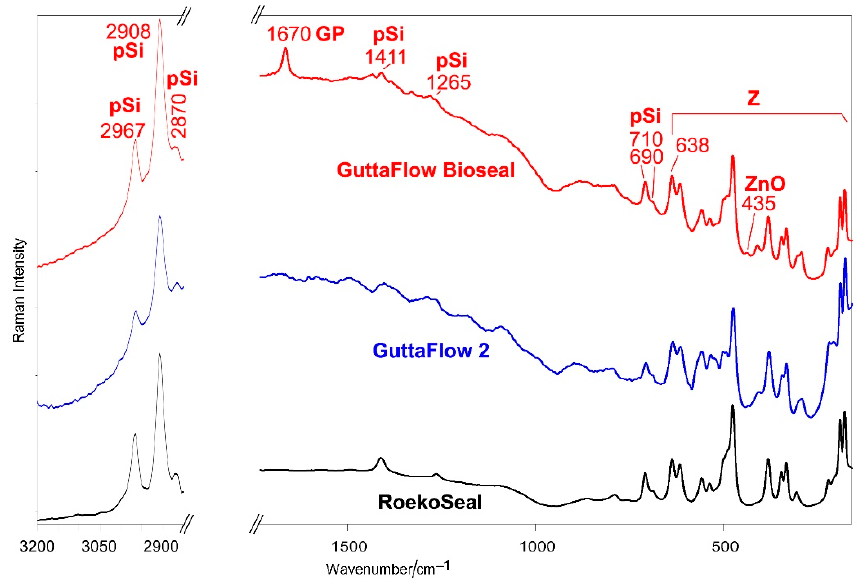
Figure 5. Average FT ‐ Raman spectra of fresh RoekoSeal, GuttaFlow 2, and GuttaFlow Bioseal. The spectra are normalized to the intensity of the 638 cm − 1 band. The bands assignable to monoclinic zirconia (Z), polydimethylsiloxane (pSi), zinc oxide (ZnO), and gutta ‐ percha (GP) are indicated. More detailed assignments are summarized in Table S2, Supplementary Material.